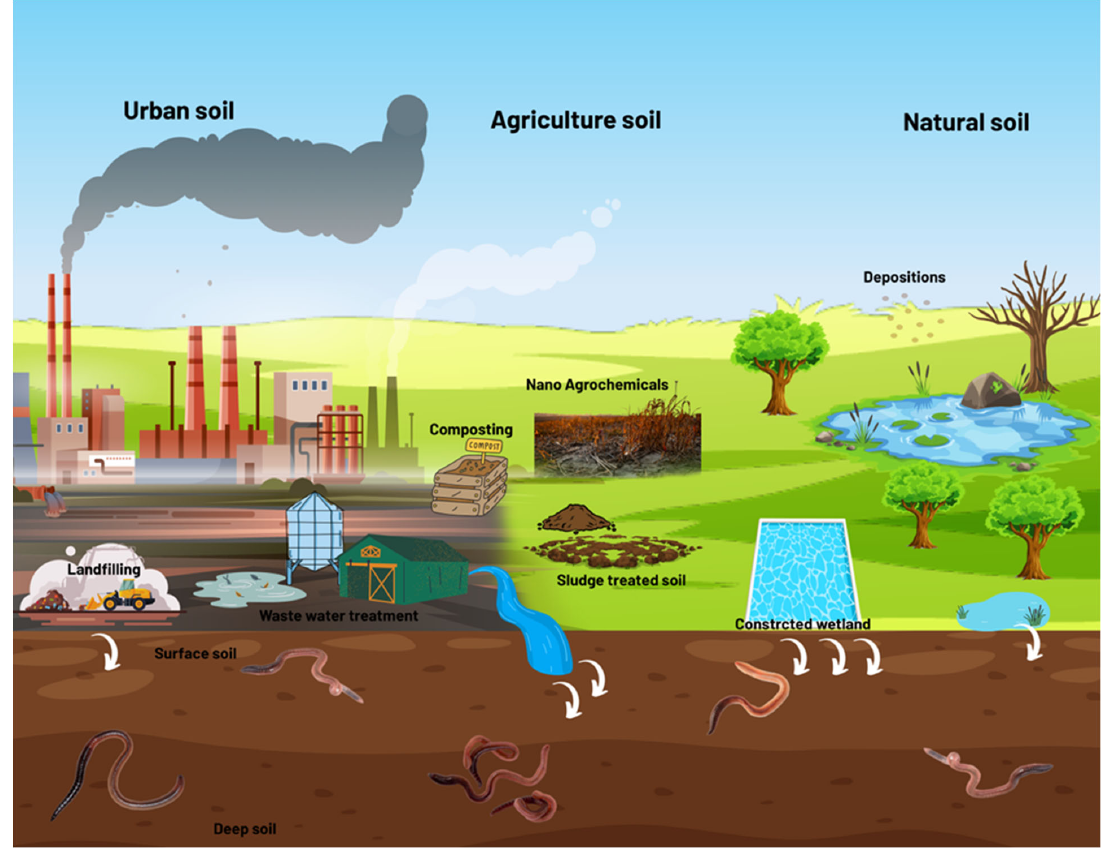
Figure 4. An outlook of MNOs possible pathways for earthworms.